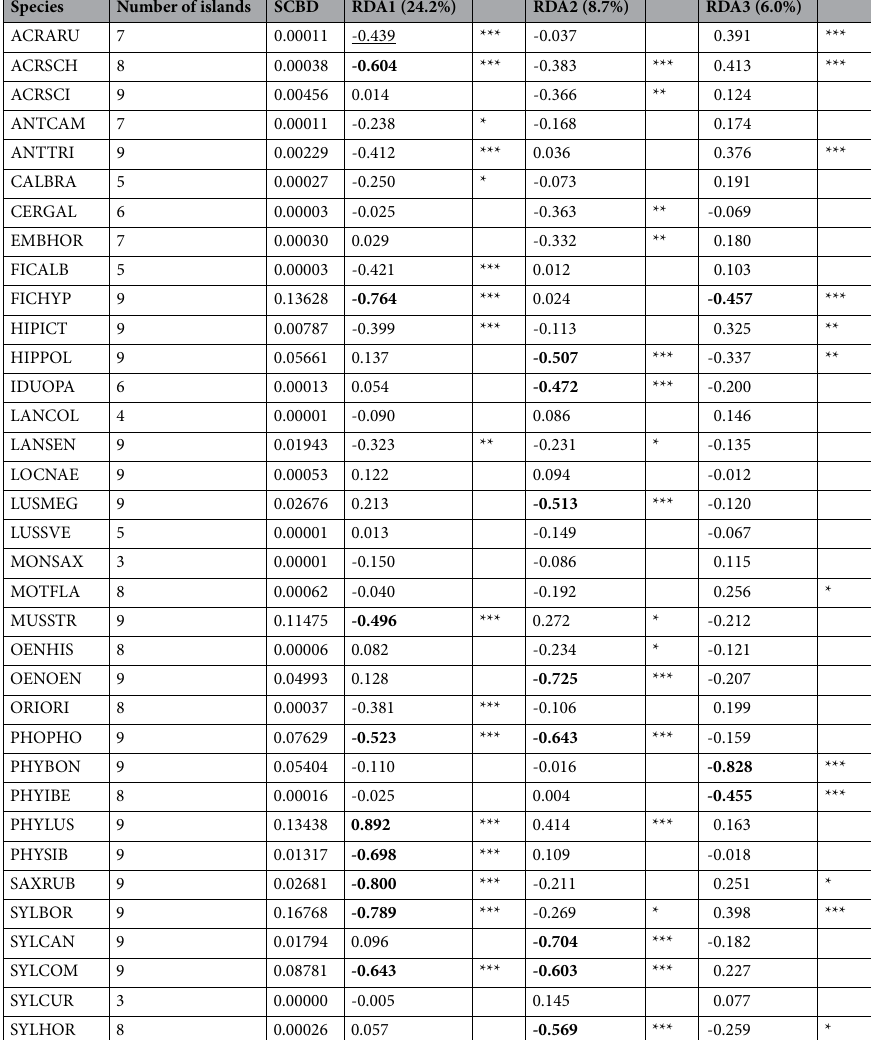
Table 4. Contribution of each species to beta diversity (SCBD) and correlation of their abundance index (chord transformed) with the three significant axes obtained from RDA. Parentheses in each axis heading show the percentage of total variability explained by each axis. Number of islands where each species was ringed in at least one year is also shown. Species acronyms identification in Supplementary Table S2. *p < 0.05, **p < 0.001, ***p < 0.001. Significant correlations after Bonferroni correction are shown in bold, and marginally significant correlations (p < 0.1) after that correction are